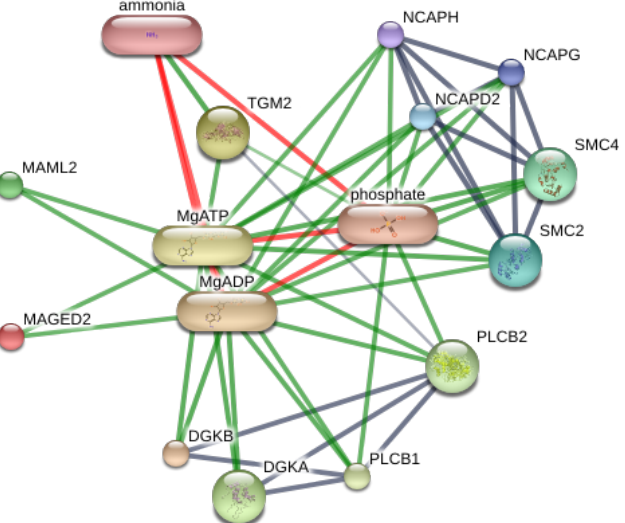
Figure 3. Contribution of DGKB, MAML2, SMC4, TGM2 and MAGED2 in networks of protein-protein interaction and protein-chemotherapy interaction of Equus caballus. Abbreviations: DGKA; diacylglycerol kinase alpha, DGKB; diacylglycerol kinase beta, MAML2; mastermind like transcriptional coactivator 2, SMC4; structural maintenance of chromosomes 4, TGM2; transglutaminase 2, MAGED2; melanoma antigen family D2 in Equus caballus that computational prediction between organism and interaction aggregated by the Stitch program (www.stitch.embl.de, accessed on 10 September 2021) Version 5.0.